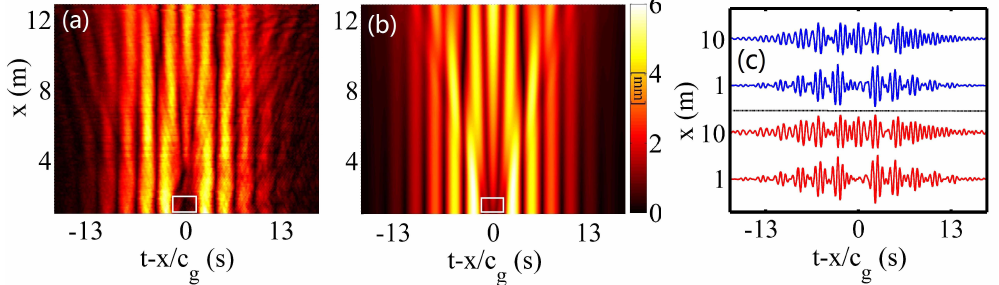
Figure 7. A theoretical plot and experimental verification of the self-healing property of surface gravity wavepackets with a Cosine-Gauss shape. The related parameters are: a 0 = 6 mm, θ = 7.5 ◦ , t 0 = 9 s. ( a ) Experiment and ( b ) simulation for the pulse envelope evolutions. ( c ) The measured elevation wave groups at two different locations. The blue curves are given by a simulation while the red curves are given by an